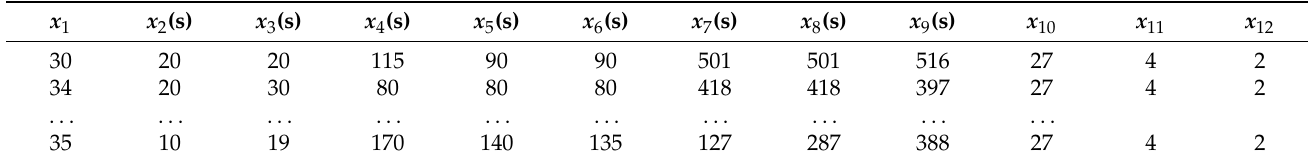
Table 3. Data samples of feature vectors.